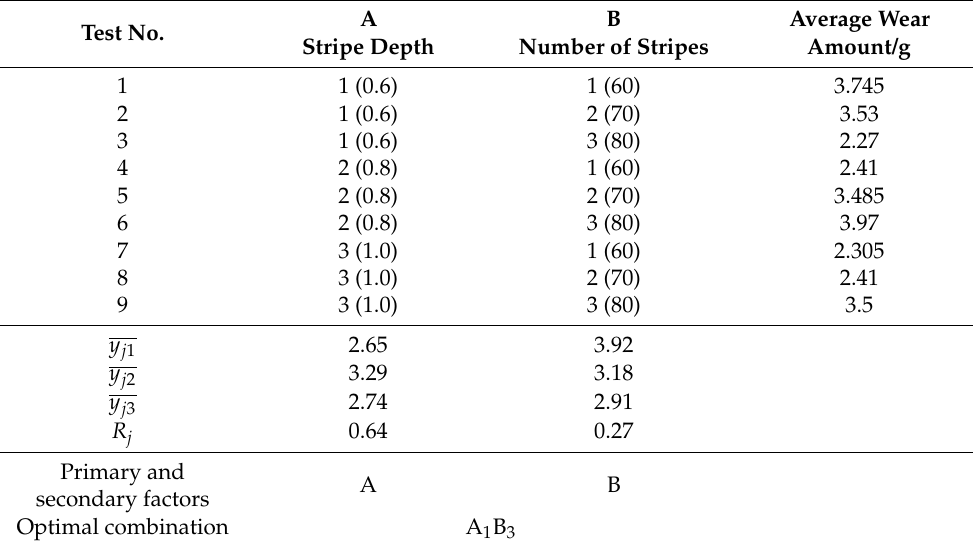
Table 3. Range analysis of wear test of the bionic grinding roller.